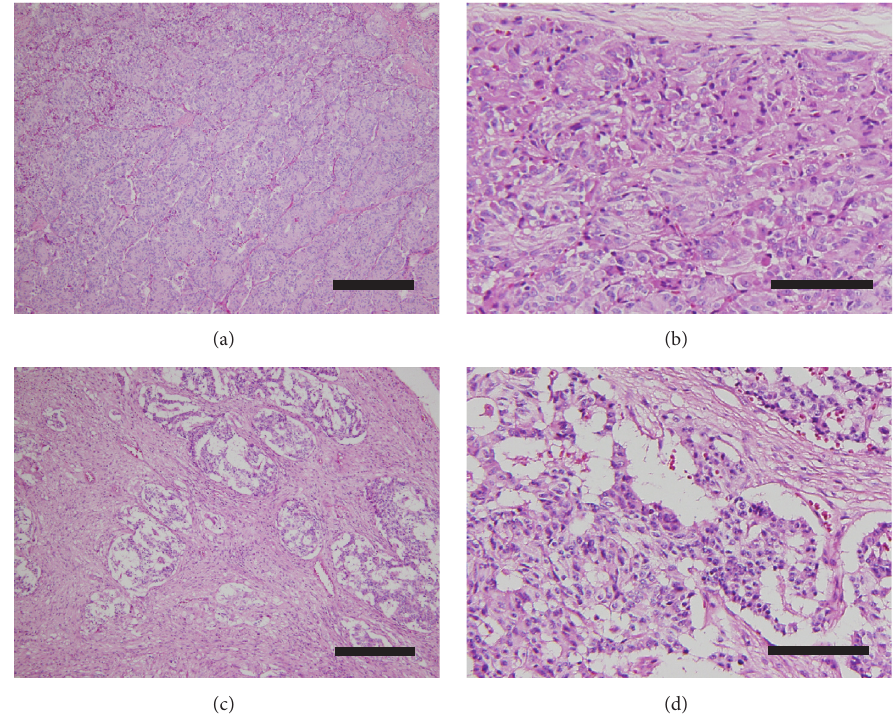
Figure3:(a)Photomicrographshowingalow-powerfieldofthegangliocyticparaganglioma(GP)sitewithadenseproliferationofepithelioid cells. Nested and compactly arranged epithelioid cells comprise the majority of the tumor (HE staining; magnification, × 100; the scale bar represents 300 𝜇 m). (b) Photomicrograph showing a high-power field of the GP site. The epithelioid cells have round to oval-shaped nuclei, inconspicuous nucleoli, and eosinophilic cytoplasm. Spindle-shaped cells surround the nests of epithelioid cells and are aligned in a single layer (HE staining; magnification, × 400; the scale bar represents 100 𝜇 m). (c) Photomicrograph showing a low-power field of the GP site with sporadic proliferation of epithelioid cells. A chaotic arrangement of epithelioid cells and a predominance of stromal cells are seen (HE staining; magnification, × 100; the scale bar represents 300 𝜇 m). (d) The epithelioid cells show a random arrangement, and spindle cells in the stroma are arranged in an irregular pattern (HE staining; magnification, × 400; the scale bar represents 100 𝜇